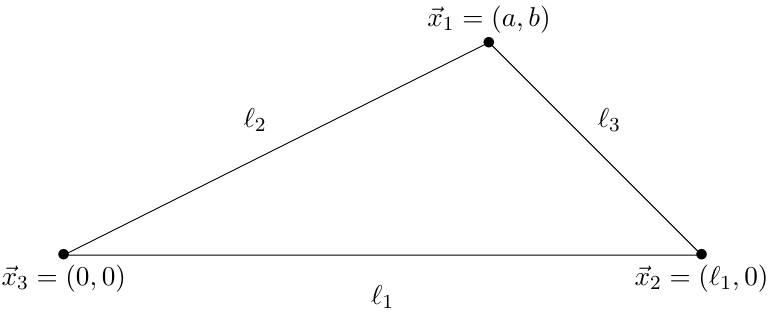
Figure 1. When the triangle inequality is satis(cid:12)ed, ‘ 2 + ‘ 3 > ‘ 1 , the points belong to a spatial plane and all three times can be chosen to be zero. By choosing an appropriate reference frame the points can be brought to the con(cid:12)guration shown in this picture.